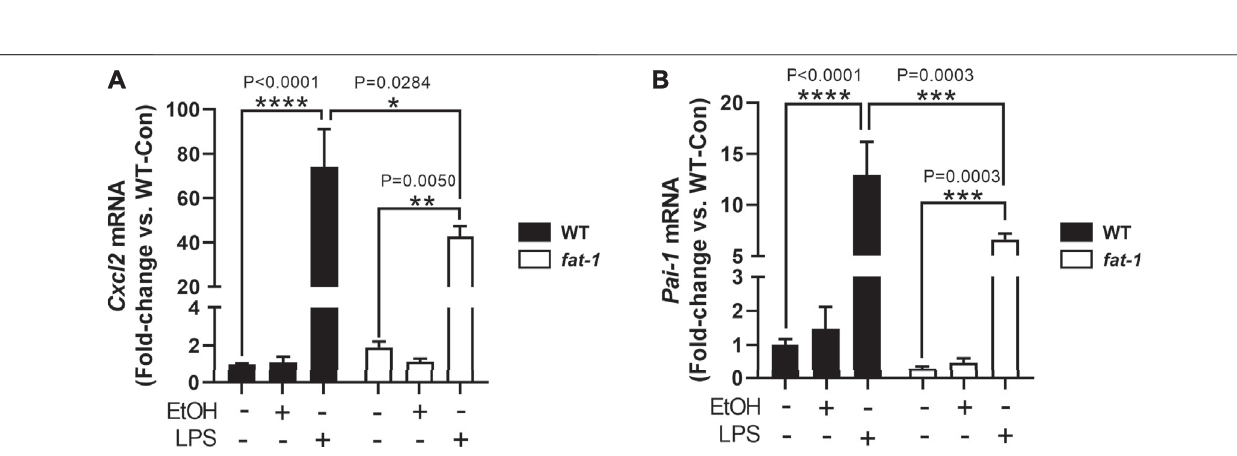
Frontiers in Pharmacology |